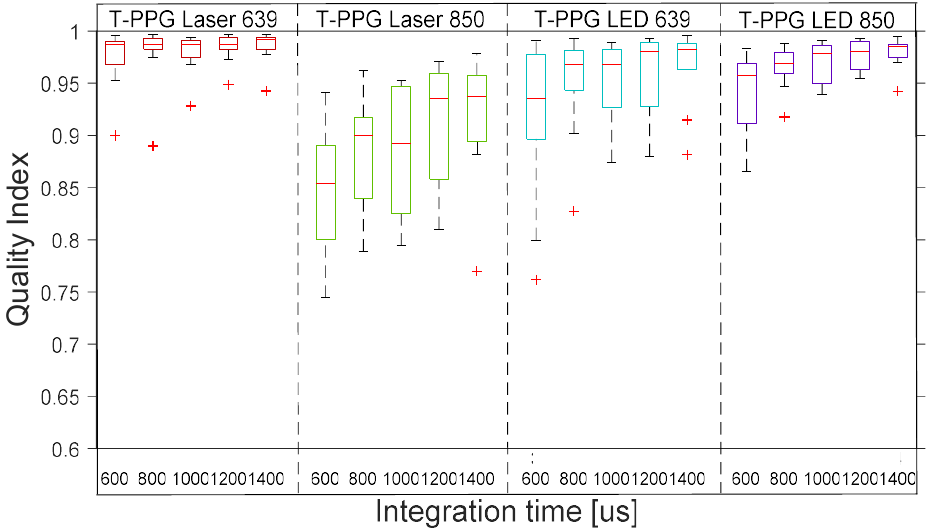
Figure 9. Boxplots of quality index of rPPG signals with 4 different lights at 5 integration times in transmission. The inner box divisions indicate: Q1 (the first quartile) to Q3 (the third quartile). The median is marked by a line across the box. The “whiskers” indicate results from Q1 and Q3 to the most extreme data points. The + symbols represent outliers.